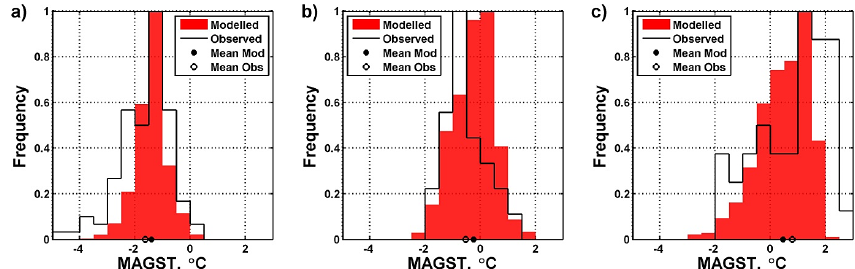
Figure 5. Distribution of modeled (red bars) and observed (black line) MAGST at the (a) Ny-Ålesund, (b) Juvvasshøe and (c) Finse field sites. Average MAGST is marked with a black dot (modeled) and circle (observed) on the x